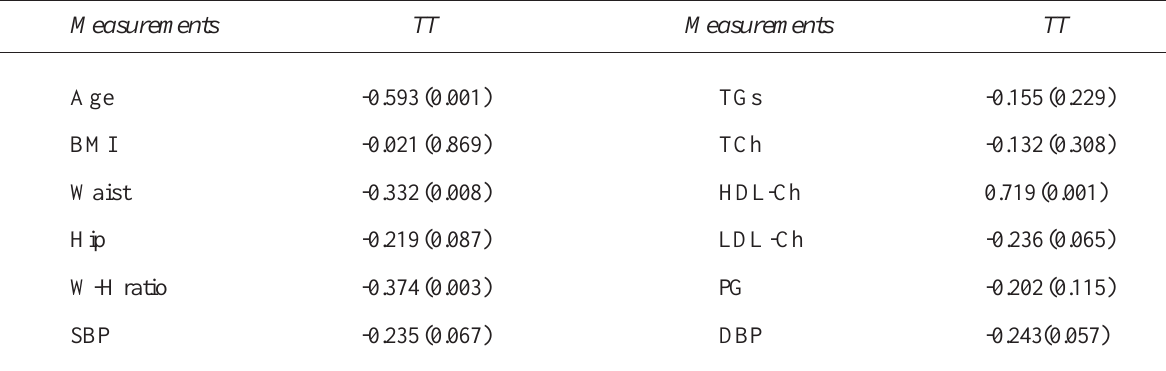
Table 3. Relationships between testosterone levels and other